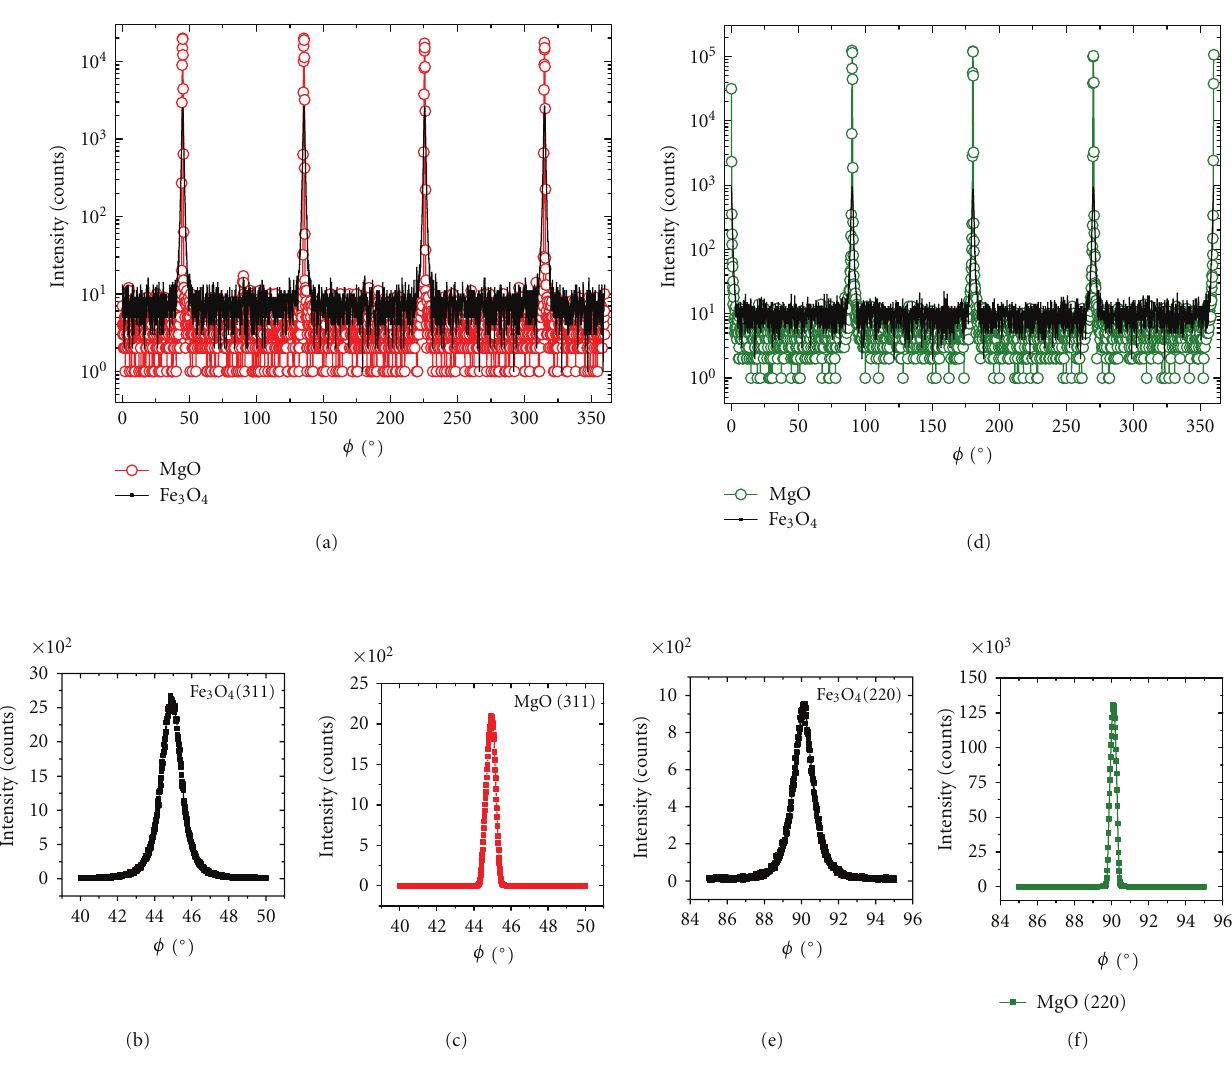
Figure 2: XRD Phi scans of Fe 3 O 4 on MgO (100) substrates. (a) Complete scan on (220) plane, (b) complete scan on (311) plane, (c) MgO (220) peak, FWHM = 0.38 ◦ , (d) Fe 3 O 4 (220) Peak, FWHM = 1.36 ◦ (e) MgO (311) peak, FWHM = 0.56 ◦ (f) Fe 3 O 4 (311) peak, FWHM = 1.34 ◦ .